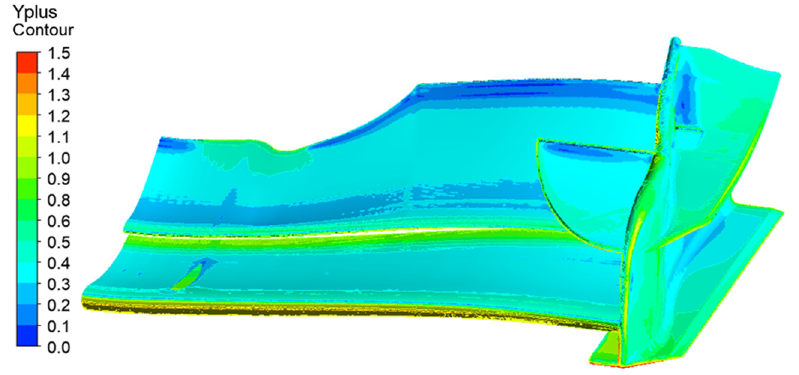
Figure 4. Wall y+ contours on the aileron’s vehicle.